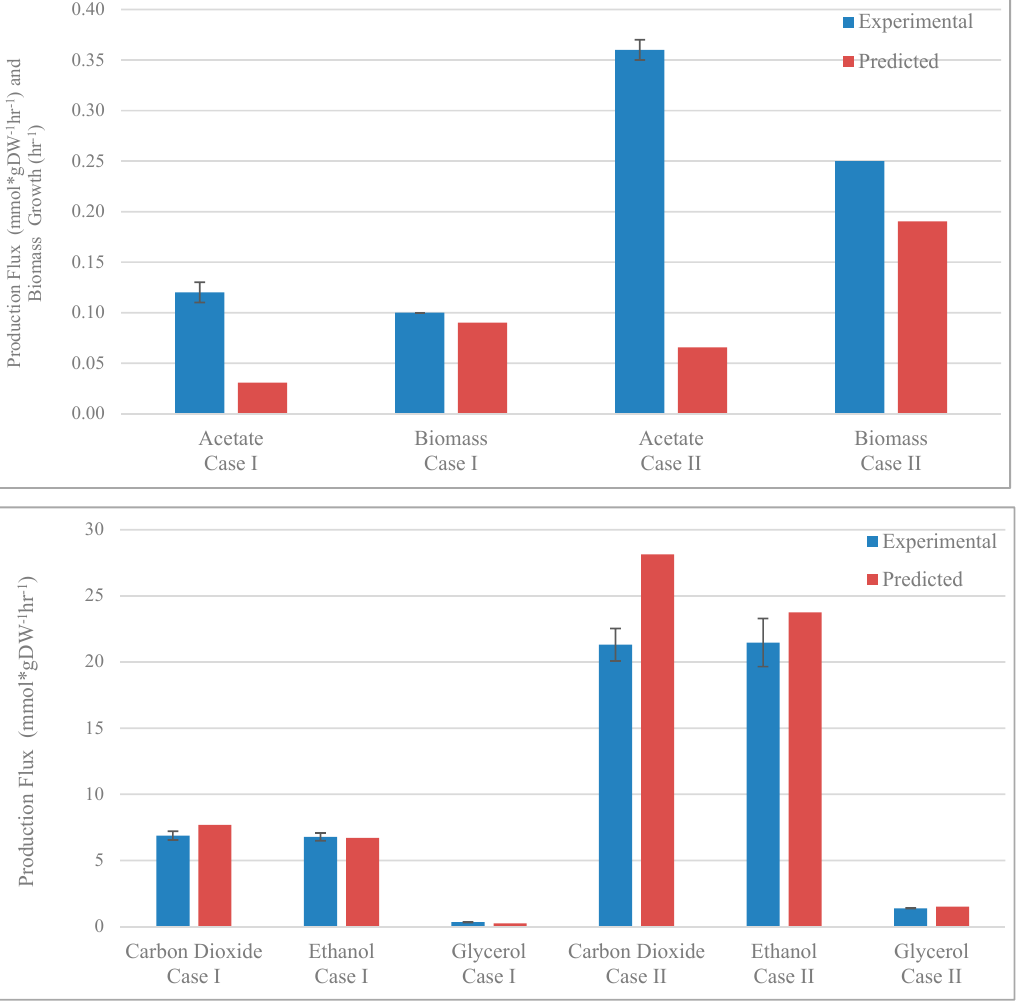
Figure 2. Comparison of GSMM simulations (red bars) with experimental data [30] (blue bars). Model predicted and experimental values for biomass growth rates, primary metabolite production fluxes, and secondary metabolite production fluxes represent conditions for Case I and Case II. Experimental data are shown with standard deviation error bars. 3.3. Analysis of Active Aroma Reactions in Metabolic Network After validating the model with existing data, it was then possible to use the model to understand the differences in metabolic states of strain EC1118 between Cases I and II. Metabolic differences are visually depicted in network maps of our two phenotypes from FBA simulations for core carbon metabolism (Figure 3), as well as sulfur and amino acid degradation metabolism (Figure 4). Additionally, more complete and integrated networks featuring metabolic flux distributions within central carbon metabolism and amino acid metabolism are shown in the Supplementary Material (see Figures S3 and S4). For central carbon metabolism the most apparent differences are concerning the pyruvate-oxaloacetate node which is a major branch that functions as a linking point between glycolysis, gluconeogenesis, and the TCA cycle. Our model predicted that there is a difference in the distribution of fluxes regarding the oxaloacetate shuttle where, for Case I,